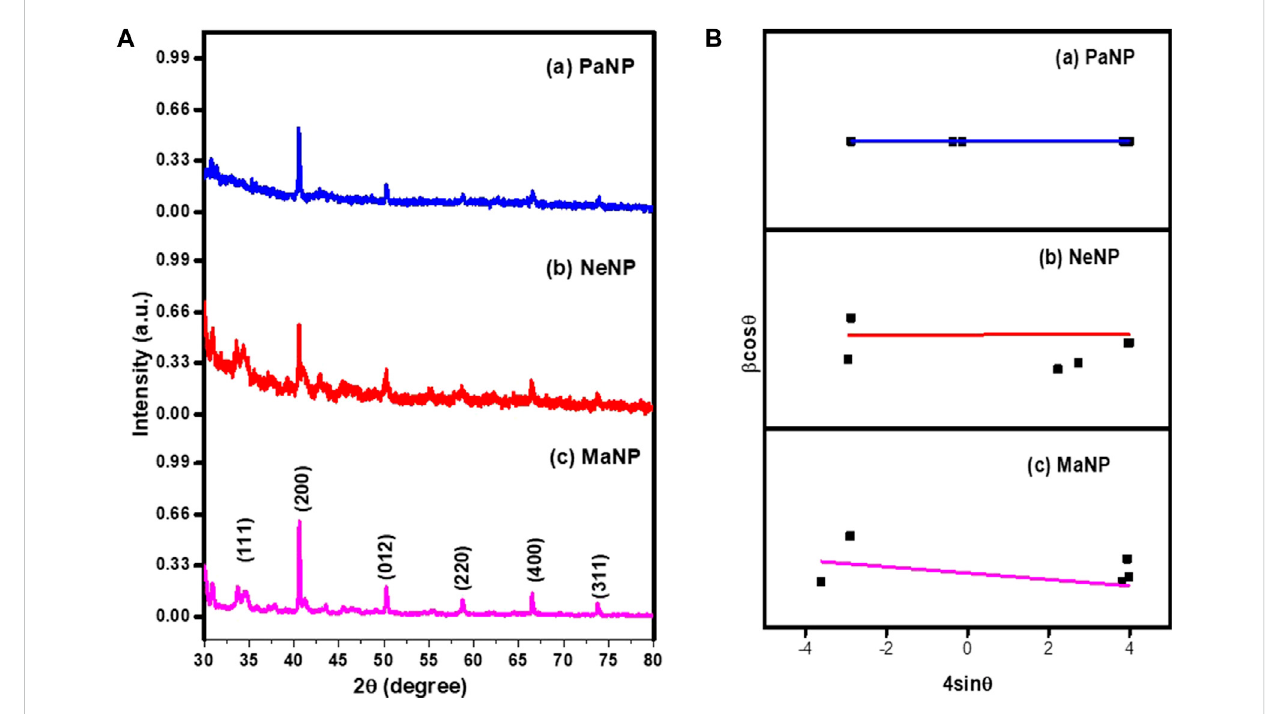
FIGURE 2 (A) PXRD pattern and (B) W-H plot of Pa, Ne, and Ma